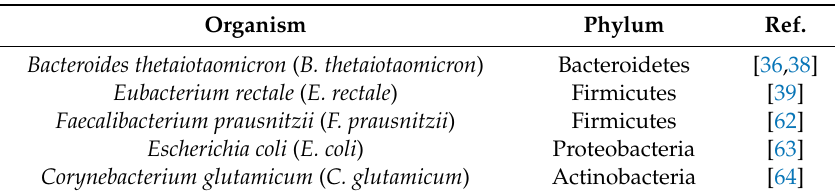
Table 1. Organisms in the community